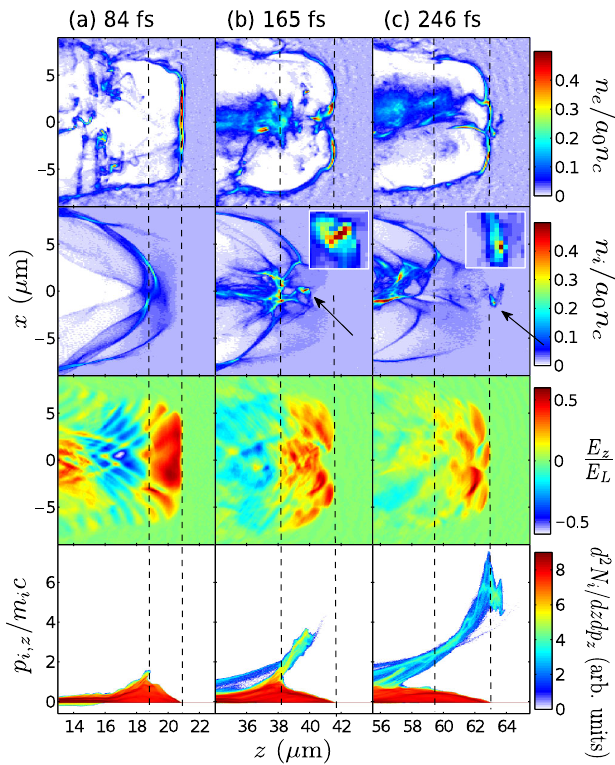
FIG. 4. Results of a 3D-PIC simulation with initial plasma density n 0 ¼ 3 n c and laser amplitude a 0 ¼ 155 ; results are shown as cuts in ð x; z Þ plane at y ¼ − 0 . 1 μ m. From left to right, results at different times: (a) 84 fs, (b) 165 fs, (c) 246 fs. From top to bottom, distribution of electron density ( n e =a 0 n c ), ion density ( n i =a 0 n c ), electric field E z =E L , and ions in ð z; p z Þ phase space (arbitrary units). The dashed black vertical lines mark the location of the laser-driven electron layer (right line) and the trailing ion layer (left line) with the positive electric field in between. Inserts ( 1 μ m × 1 μ m) in the ion density panels show blow-ups of the ion blobs (marked by black arrows), captured and accelerated in this field [column (b)] and just emerging in front of the electron layer [column (c)].